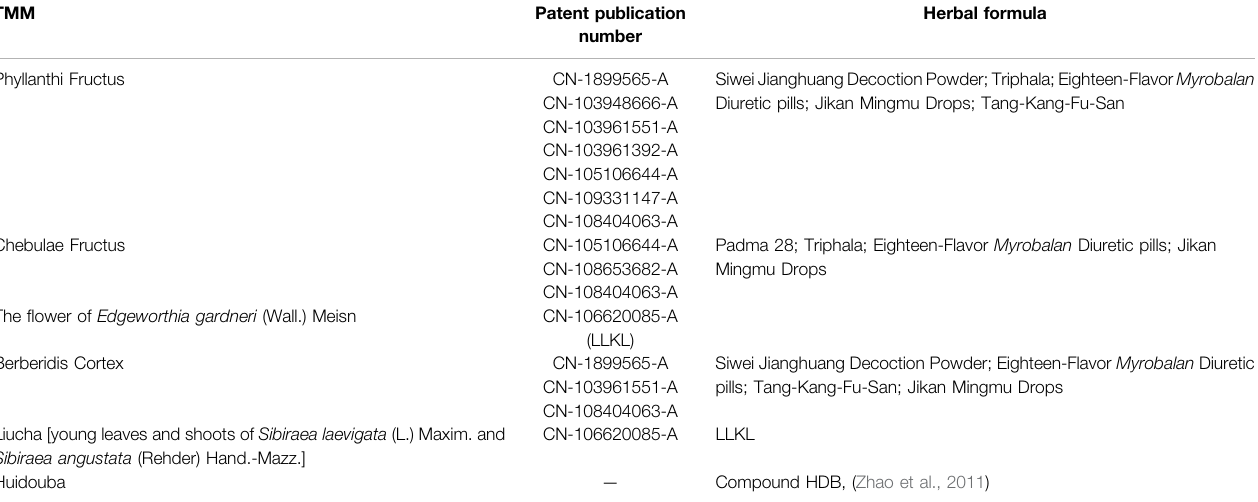
TABLE 2 | TMM used in anti-DM prescriptions and registered